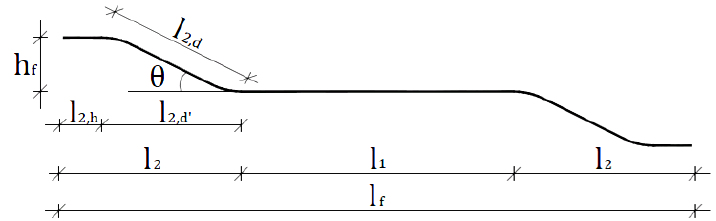
Figure 1. Typical geometry of a hooked fiber bar of diameter d f . Dimensions and properties of the fiber used for the case study are shown in Appendix A.